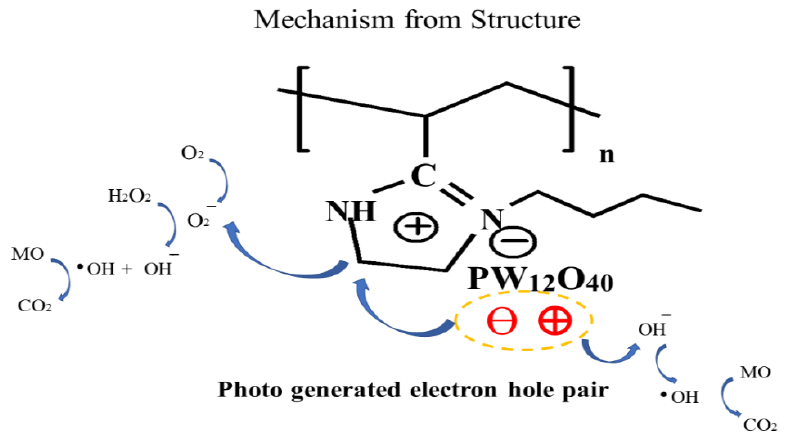
Figure 5. Energy-band diagrams for PW-PIL structure, and the separation of charge carriers under irradiation.